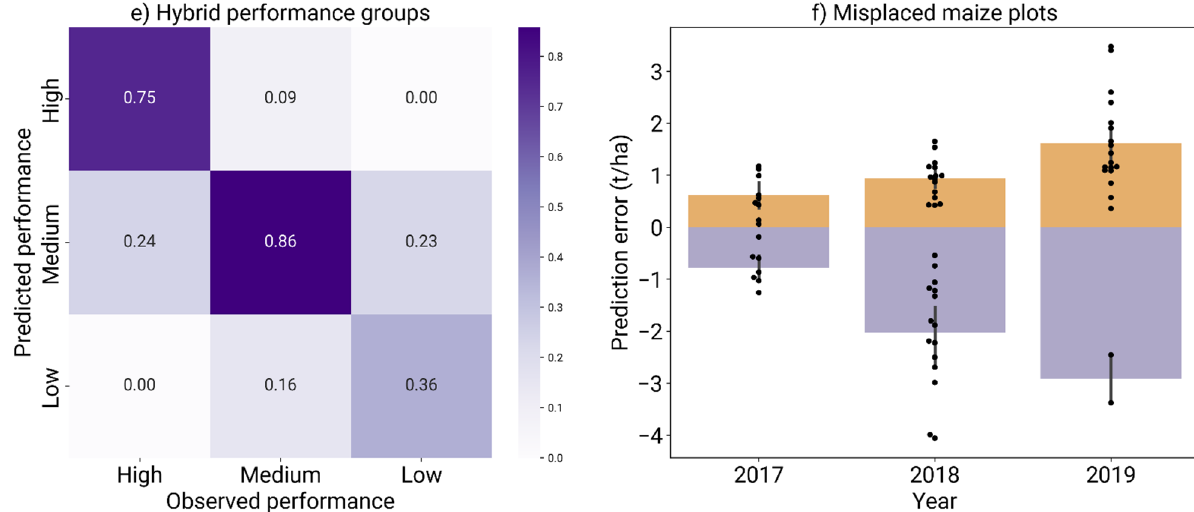
Figure 7. Images ( a – d ) shows the multimodal fusion model prediction of grain yield (t/ha) from each module and the weighted prediction. Each module prediction is based on their specific data modality, whereas the weighted prediction is obtained by scaling each module’s prediction and summing the predicted yield. Image ( e ) shows the model prediction of each maize plot as high-, medium- and low-yield plots (in the y axis), comparing their ground-truth yield in the x -axis. The values within the square indicate the percentage of each category that were predicted to be high-, medium- and low-yield plots. Image ( f ) shows the optimization error of maize plots that presented a high yield but were predicted as medium (in light purple), and plots with a low yield that were predicted to have medium performance (mustard). The plots are separated by year.